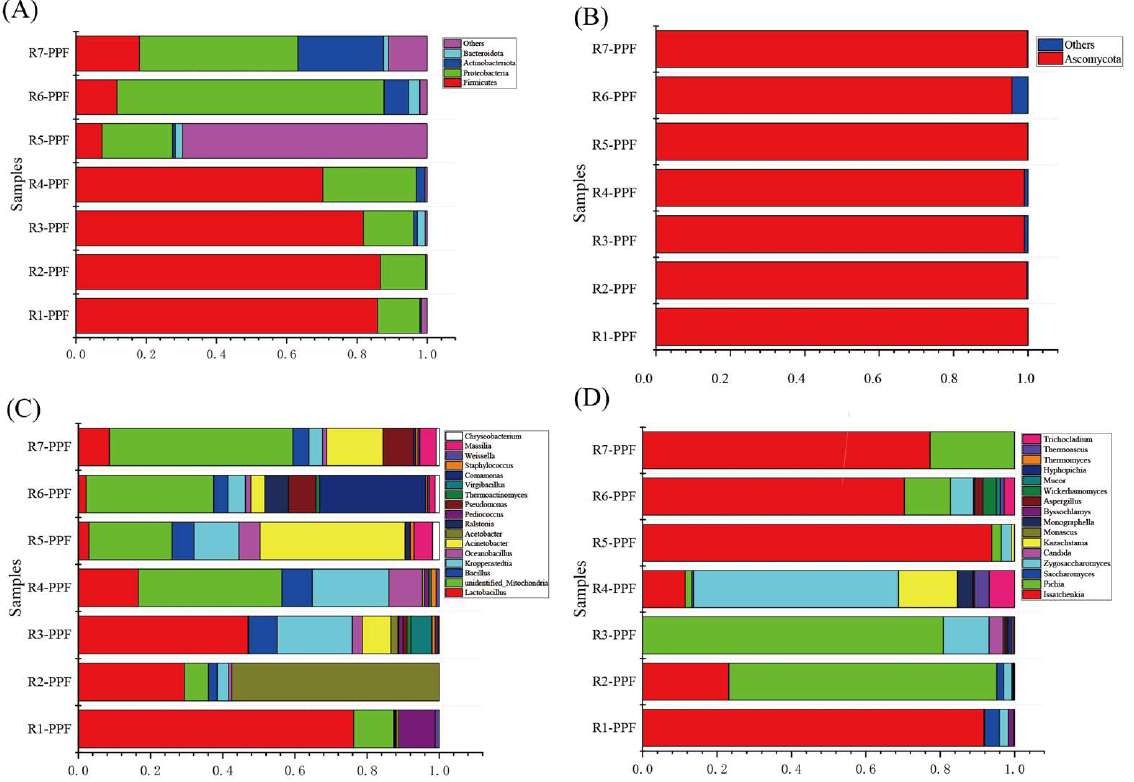
Figure 3. The composition of the microbial community over different rounds of the pre-pit fermen- tation grains. ( A ) Percent of bacterial community abundance on phylum level. ( B ) Percent of fungi community abundance on genus level. ( C ) Select bacterial genera with comparative abundance greater than 0.1% for the map, containing a total of 17 bacterial genera. ( D ) Select fungal genera with comparative abundance greater than 0.1% for the map, containing a total of 16 fungal genera. Table 3. Core microbe, dominant microbe, and characteristic microbe during different rounds of pre-pit fermentation grains.